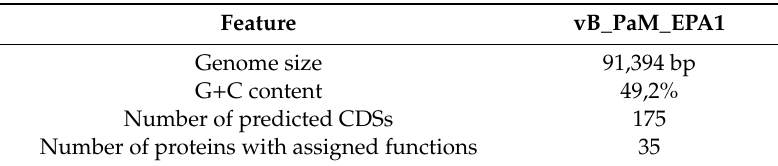
Table 1. General features of EPA1